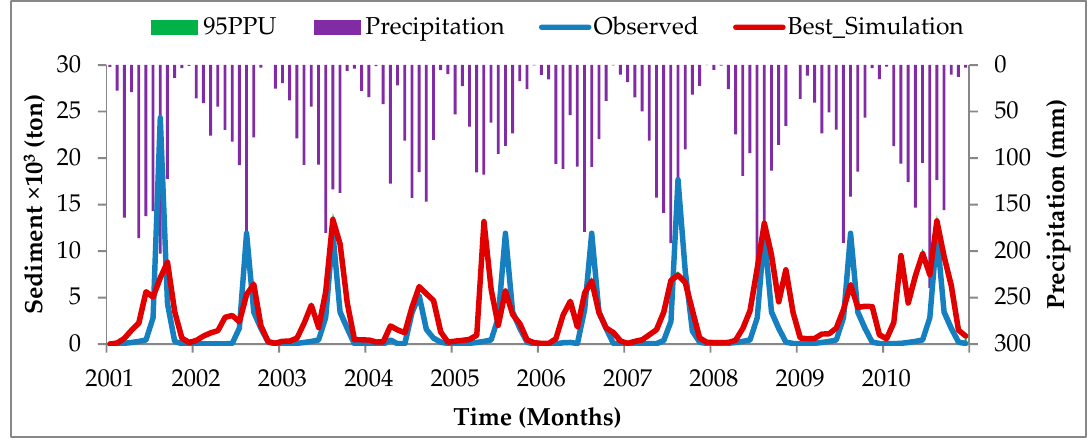
Figure 7. Sediment yield validation for the Ketar River.